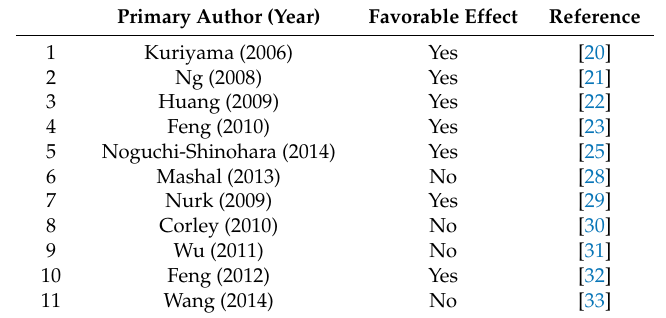
Table 1. Examples of observational epidemiological studies on the effect of tea consumption on cognitive decline or